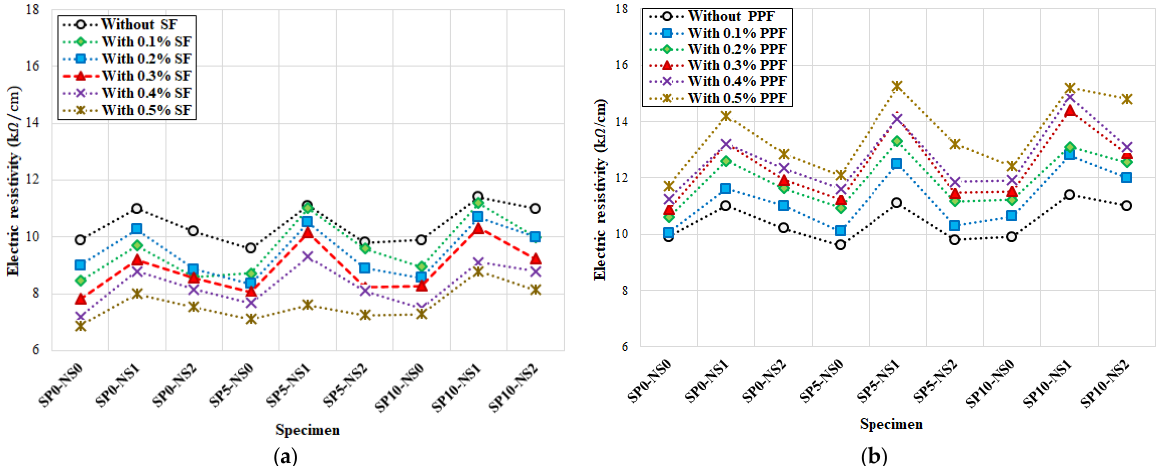
Figure 20. Influence of the fibres on the electrical resistivity of HSC containing NS and SP ( a ) SF and ( b ) PPF.